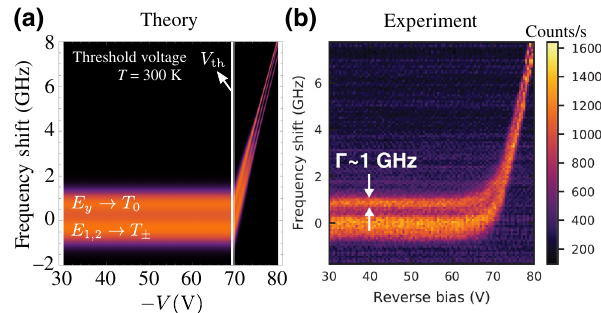
FIG. 7. Comparison between theory (a) and experimental data from Ref. [1] (b) [reprinted with permission from AAAS] for photoluminescence of a single (kk) divacancy with (cid:22) (cid:23) (cid:22) (cid:2) addressed transitions. For | V | < | V → | T and E 1,2 ± defect is within the nondepleted part of the n region, thus expe- riencing zero electric field and large electric noise and linewidth. For | V | > | V th | the charges begin to be depleted around the spin center, yielding a narrowing of the linewidth, and a shift in frequency in response to the now present electric